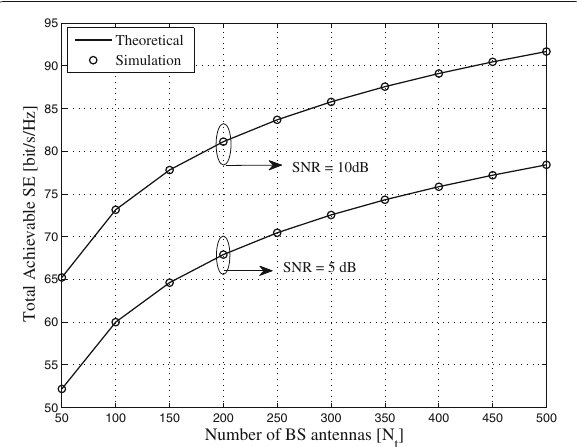
Fig. 4 The total achievable SE versus SNR for N t = 64,100 and K = 8. Results are showed for MRT without scheduling method and ZF precoding (MRT with scheduling method)